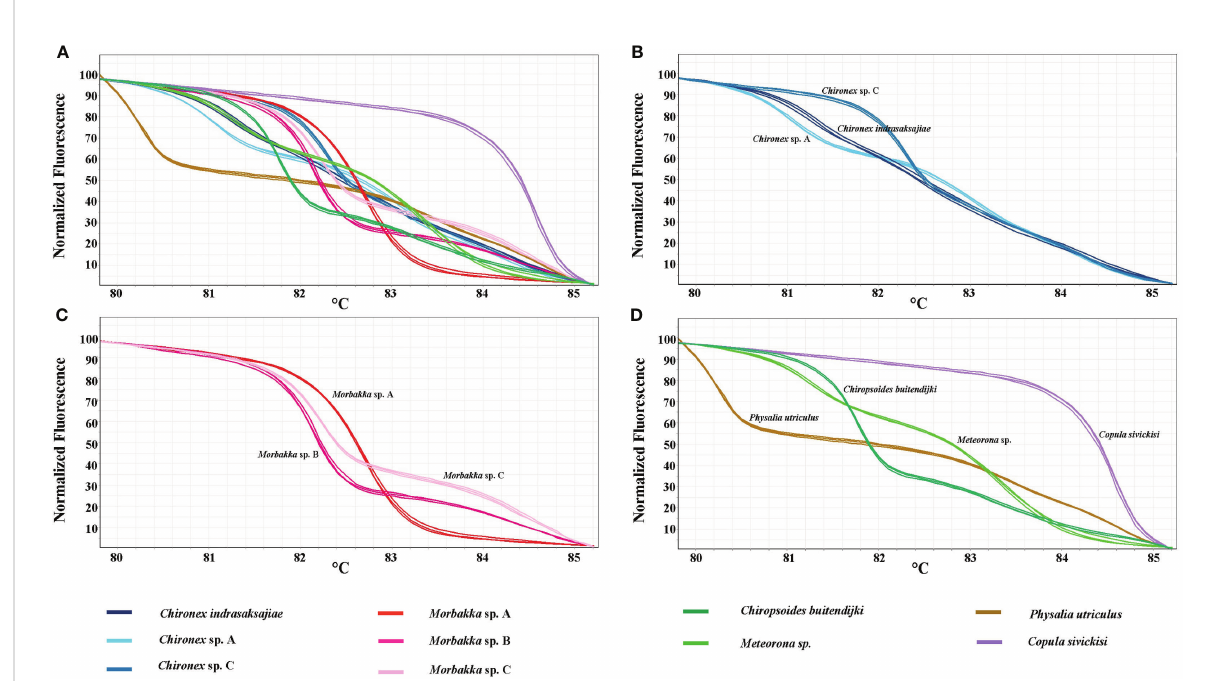
FIGURE 2 Normalized melting curves of tested jelly fi sh species. (A) all ten species, (B) Chironex species, (C) Morbakka species, and (D) Chiropsoides , Copula , Meteorona , and Physalia